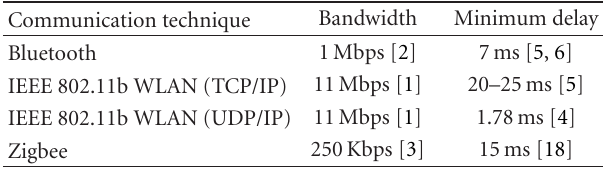
Table 1: Characteristics of several wireless communication tech-